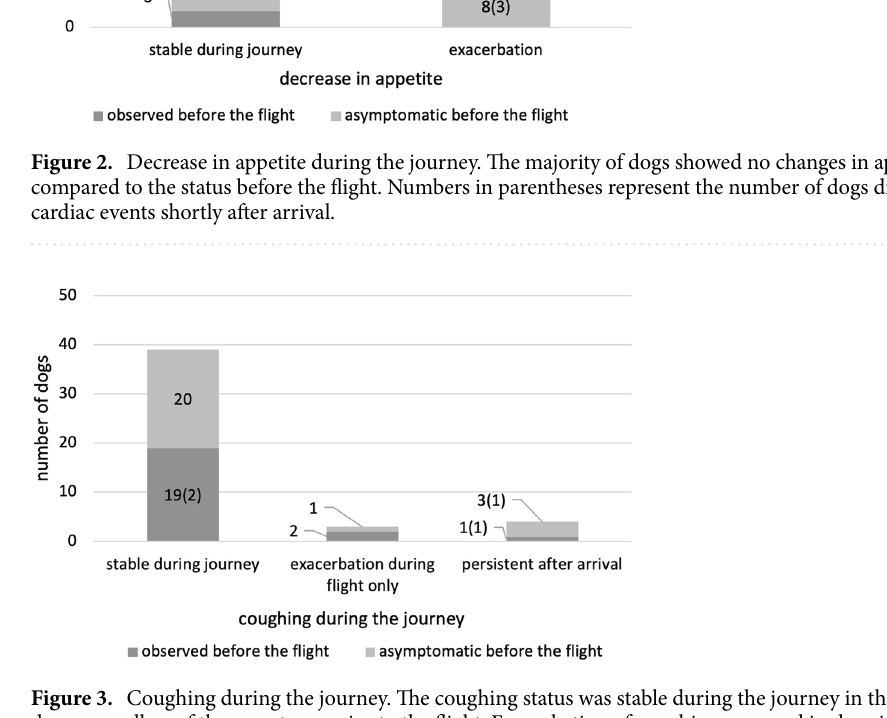
Figure 3. Coughing during the journey. The coughing status was stable during the journey in the majority of dogs, regardless of the symptoms prior to the flight. Exacerbation of coughing occurred in dogs in both the symptomatic and asymptomatic groups. Numbers in parentheses represent the number of dogs that showed cardiac events on